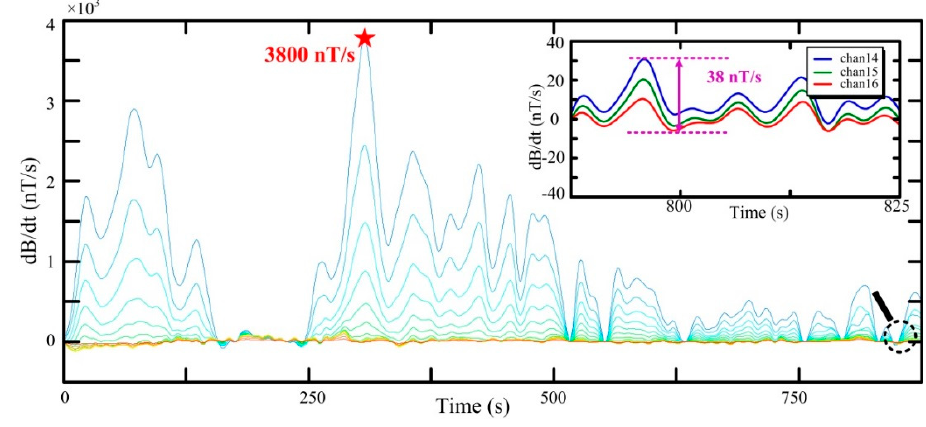
Figure 18. Flight line with air-core coil A.